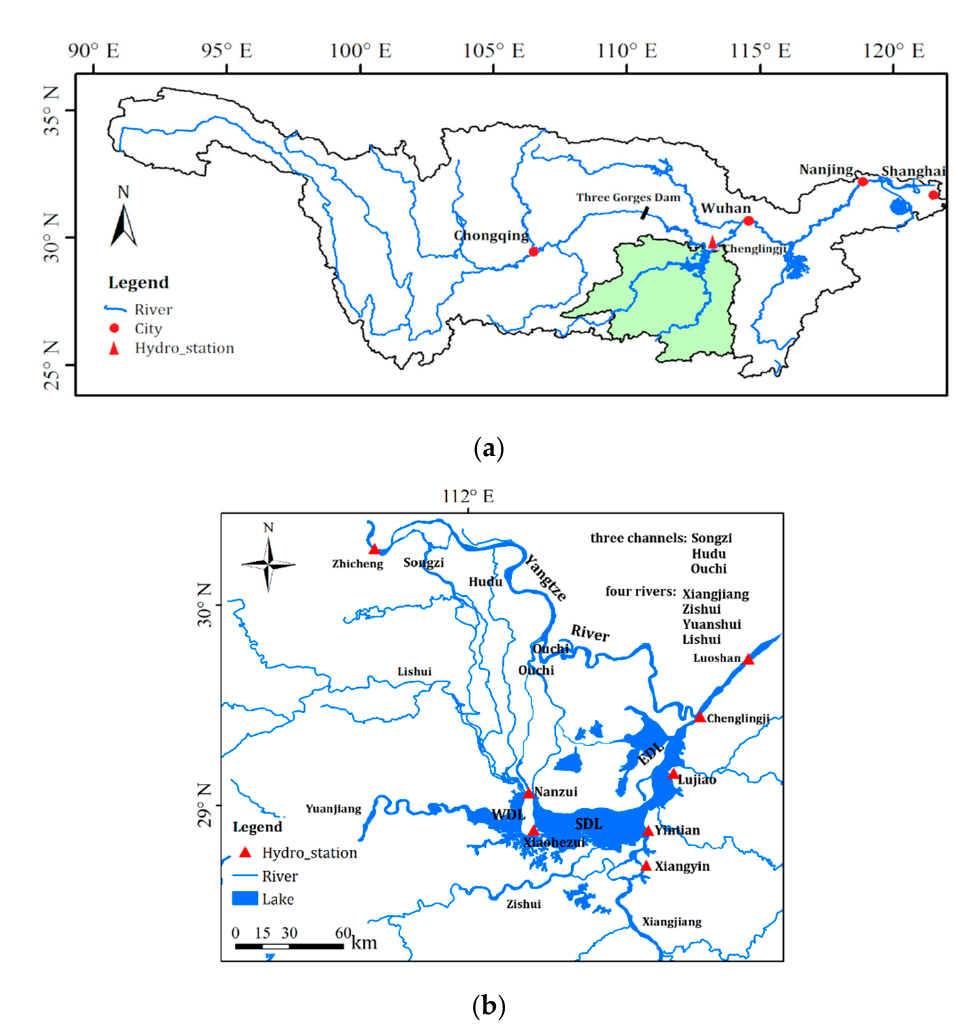
Figure 2. The location of Dongting Lake. The lake collects water from the Yangtze River through ‘three channels’ (Songzi, Hudu, and Ouchi) and ‘four rivers’ (Xiangjiang, Zishui, Yuanshui, and Lishui) and discharges to the Yangtze River at Chenglingji. ( a ) The location of Dongting Lake catchment; ( b ) Dongting lake and its main tributaries.